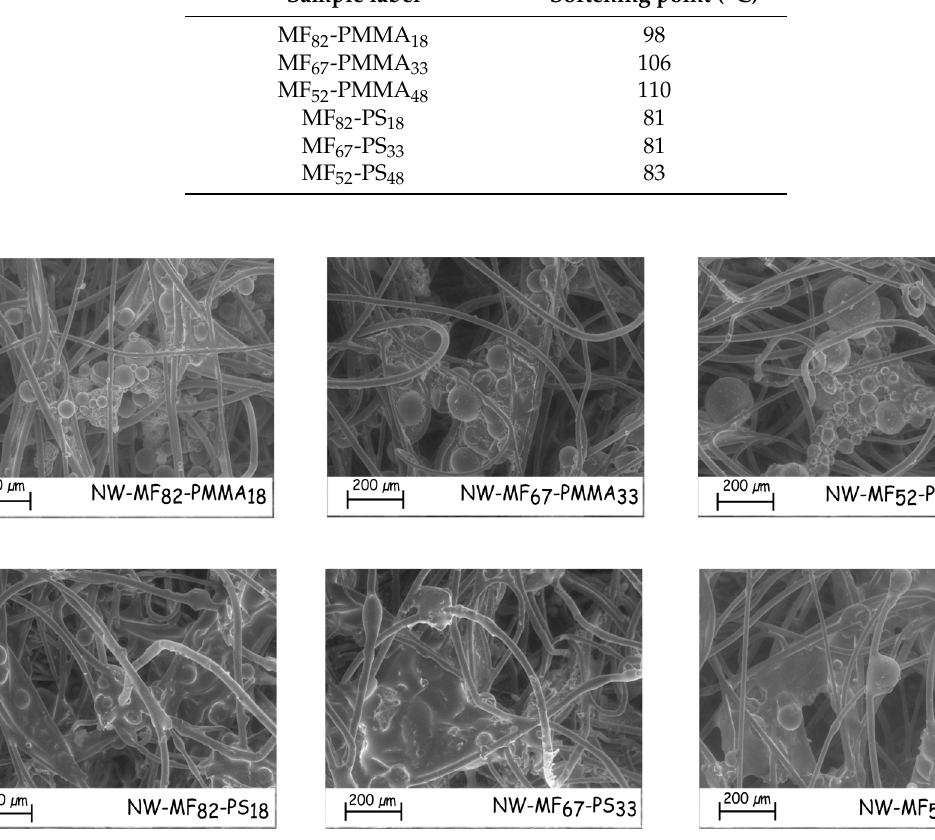
Figure 8. SEM micrographs of the impregnated nonwoven fabrics.